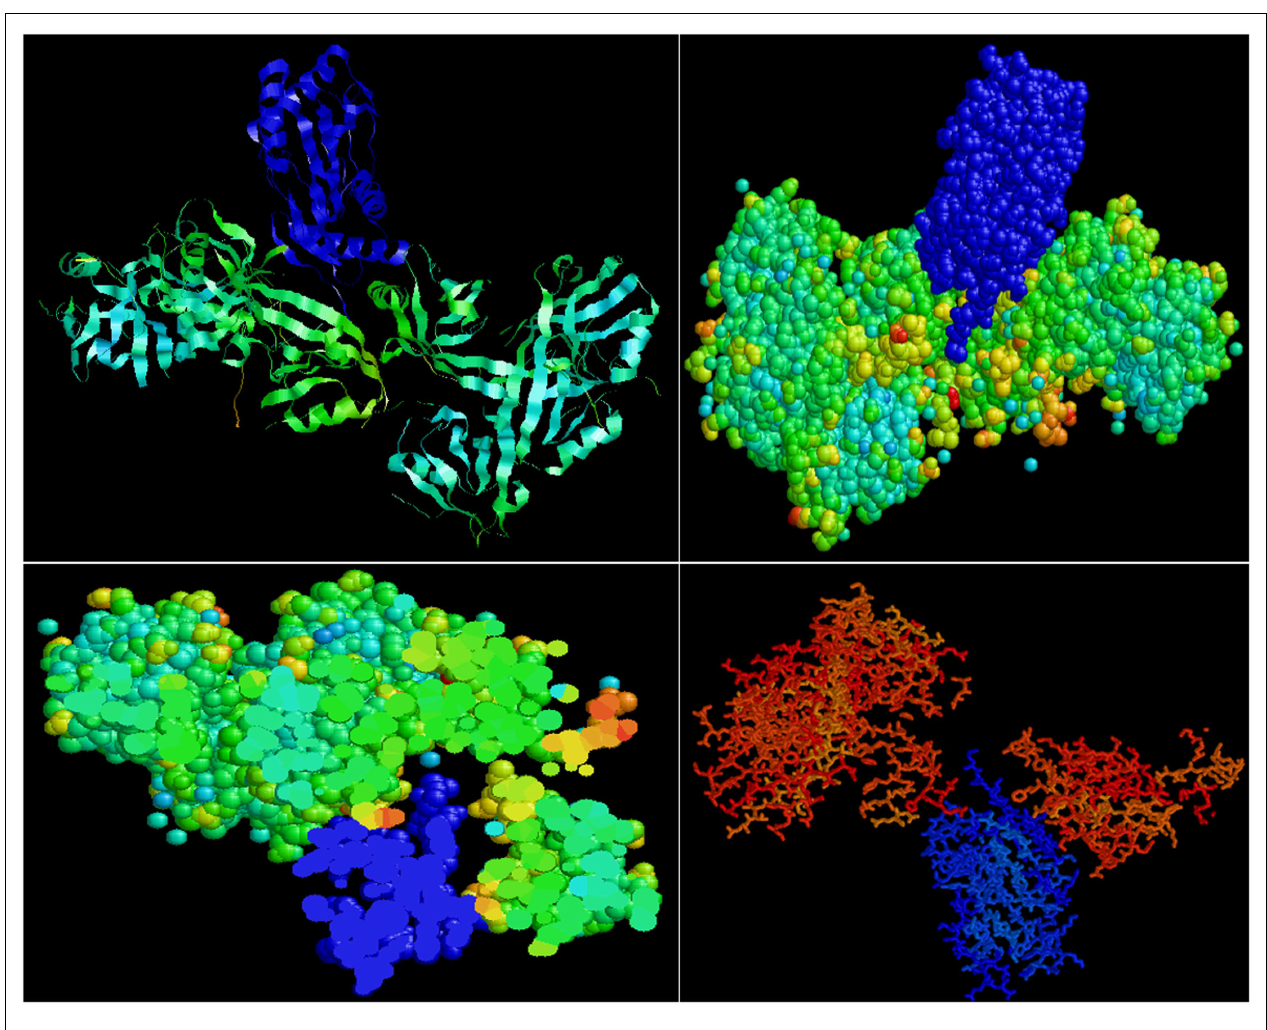
structural alignment based on lowest energy levels was visualized for ribbon and ball and stick structures using RASMOL (78) and shown in upper panels. In the lower panels, note the groove in the shank in which the LC8 (blue) fits. Such conformation may offer dynamic stability to shank–LC8–nNOS complex during transport at the periphery of nerve